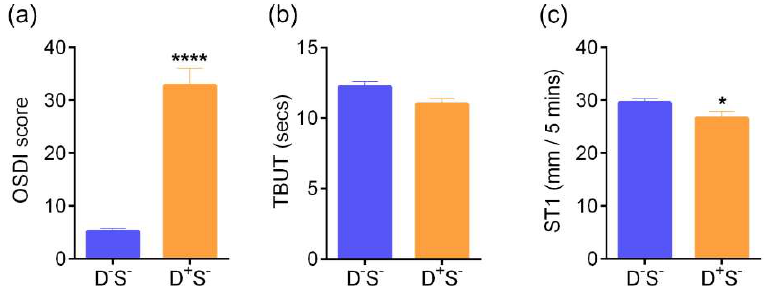
However, no significant differences in the tear soluble factors were observed between D ++ S - compared to D - S - groups (Table 1).